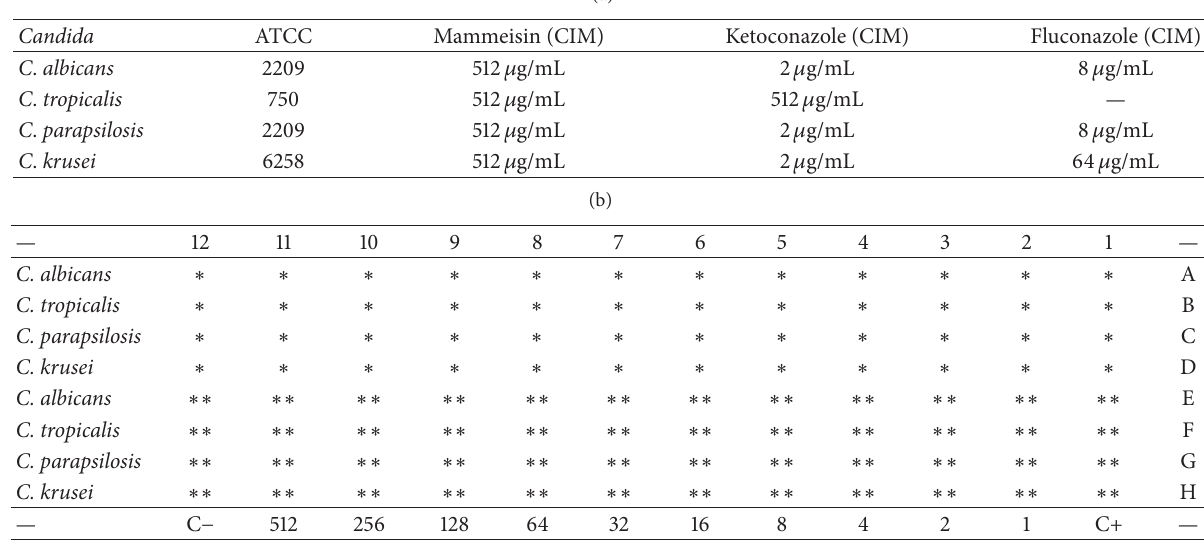
Table 1: Summary of the minimum inhibitory concentration (MIC) for mammeisin and two antifungal agents. (a)